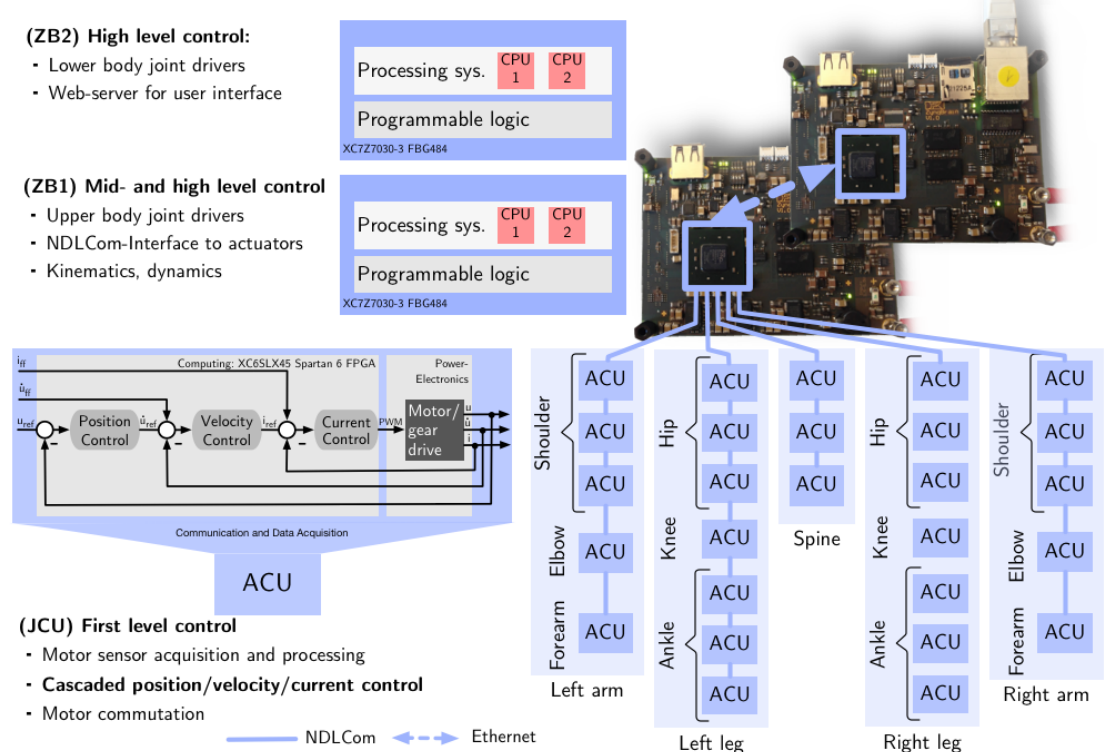
Figure 5. Hybrid centralized-decentralized control and network architecture. The exoskeleton is controlled by two central systems, called ZynqBrain (ZB), and a network of decentralized Actuator Control Units (ACU) for BLDC motor control. Each motor is controlled locally by an adjacent ACU. The distributed ACUs are interconnected via an NDLCom network. ACUs that belong to a specific limb form a subsystem. Bottom left: cascaded actuator-level control architecture implemented on the FPGA of each ACU; u is the angular position, ˙ u is the angular velocity and i is the motor current. The reference values are provided by the mid-level control on the ZBs. All ACUs continuously send telemetry status data including u , ˙ u and i to ZB1 with a frequency of 100Hz using the NDLCom